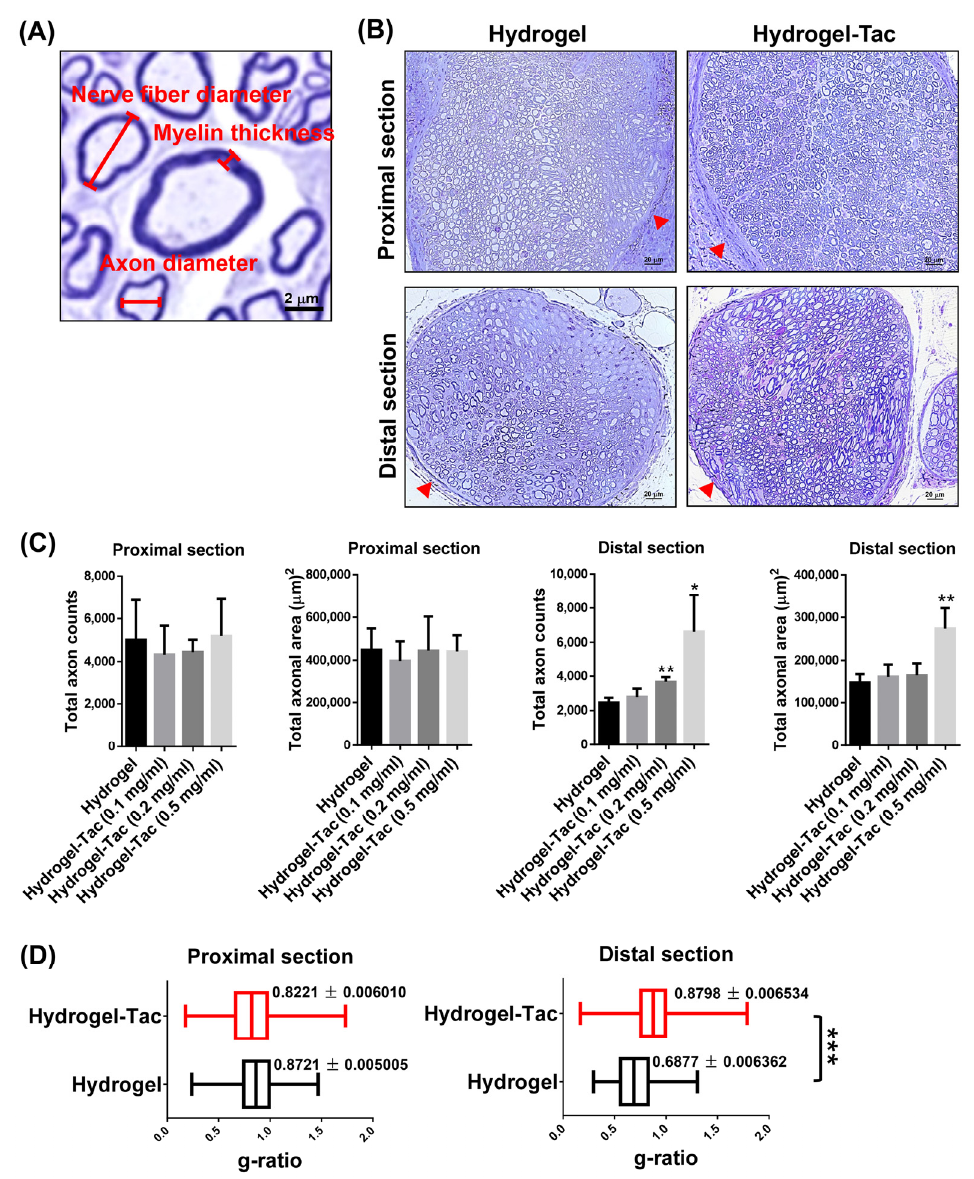
Figure 6. Axonal analysis of proximal and distal sciatic nerve ends between Hydrogel and Hydrogel-Tac groups. In both groups, the sciatic nerves of the right hindlimb were cut and then anastomosed with 10/0 sutures. Subsequently, 0.1 mL of hydrogel or encapsulated-tacrolimus hydrogels (0.5 mg/mL) were injected into the subcutaneous space of the right hindlimb. ( A ) Representative photographs of the toluidine-blue-stained sciatic nerve. The labeled bars represent the myelin thickness, nerve fiber diameter, and axon diameter. The scale bars is 2 μ m. ( B ) Microscopic evaluation of the cross-sectional and toluidine-blue-stained sciatic nerves in both groups on POD 225. The perineurium is indicated by the red arrow. The scale bars are 20 μ m. ( C ) The total axon counts and total axonal area in the proximal and distal sciatic nerve ends. Each group had three mice. ( D ) The g ratio in the proximal and distal sciatic nerve ends of both groups is expressed as a ratio of the axon diameter divided by the nerve fiber diameter. It reflects the nerve conduction speed. In the proximal and distal sections, both groups contained ratios of at least 1400 and 1010. The total axon counts, total axonal area, and g ratio were calculated using Image-Pro 2D/3D/4D image analysis software. The statistical comparison of mean ± SD of the hydrogel group with Hydrogel-Tac group displayed a significant difference (* p < 0.05, ** p < 0.05, *** p < 0.05, unpaired t -test).